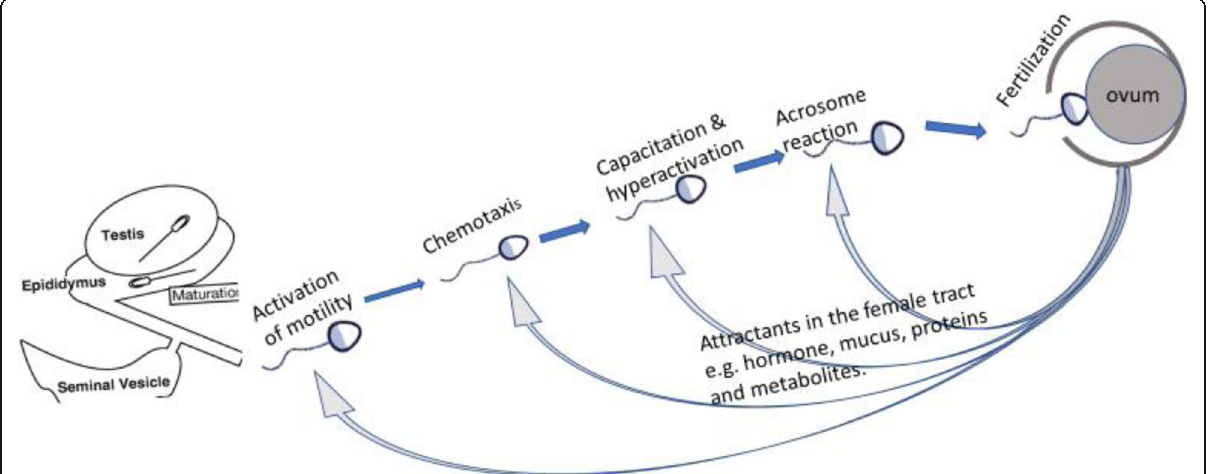
Fig. 1 Schematic progression of mature spermatozoa and the role of the female factor on different processes underlying